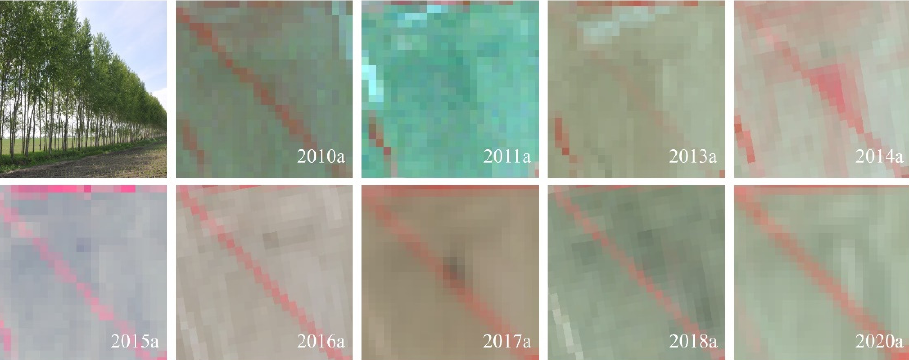
Figure 4. Changes in spectral characteristics in different Landsat images of one farmland shelterbelt planted in 2011. (The images are composited by the standard pseudo color). For Landsat-5 images: red = 0.76–0.90 µm (near-infrared band); green = 0.63–0.69 µm (red band); blue = 0.52–0.60 µm (green band); For Landsat-8 images: red = 0.85–0.88 µm (near-infrared band); green = 0.64–0.67 µm (red band); blue = 0.53–0.59 µm (green band)).